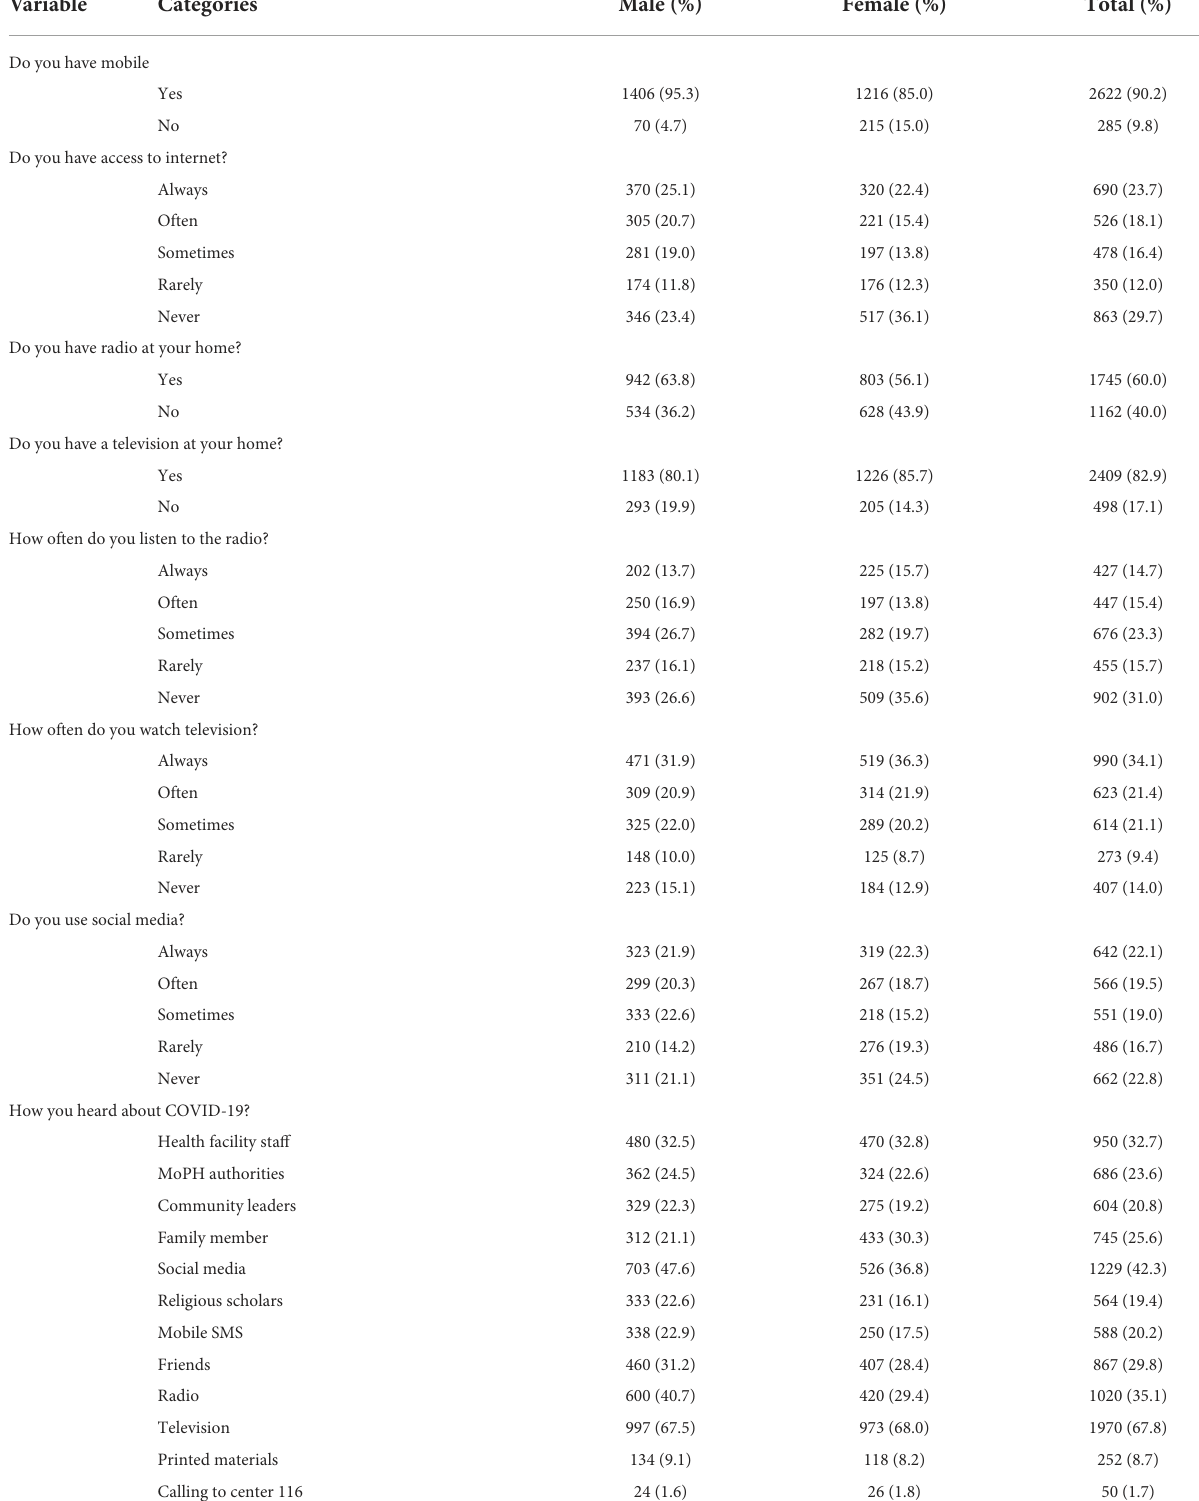
TABLE 9 Frequency distribution of source of information about COVID-19 ( N =